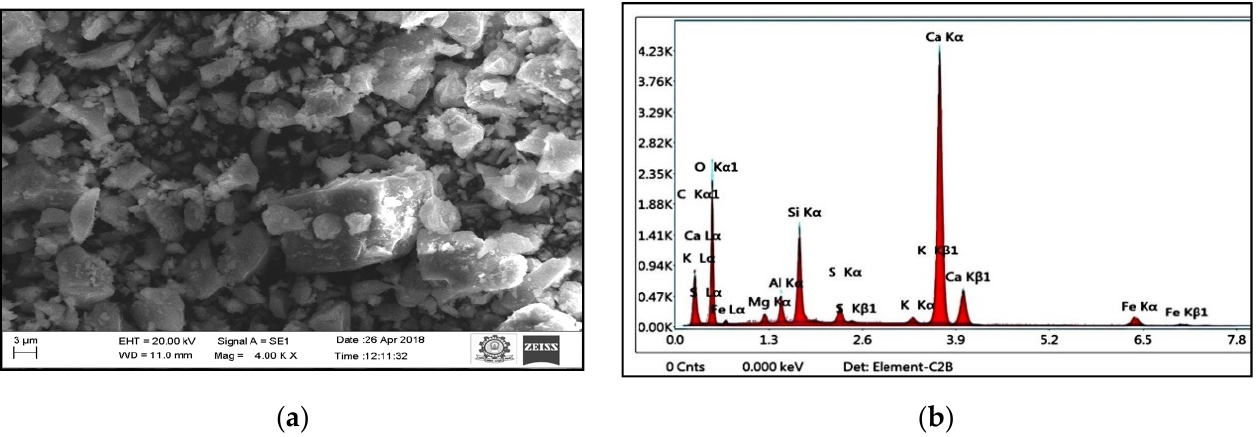
Figure 1. ( a ) SEM image of OPC 53 grade cement; ( b ) EDAX image of OPC 53 grade cement.